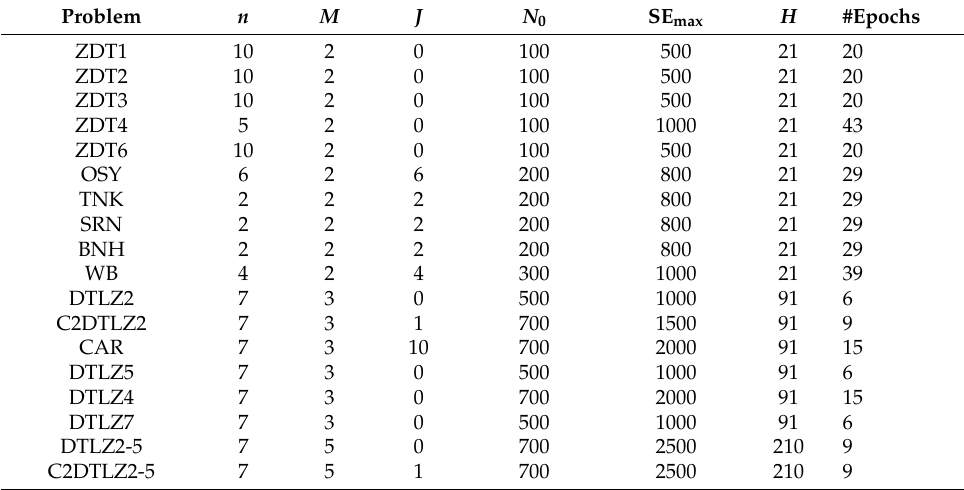
Table 2. Parameter values for 18